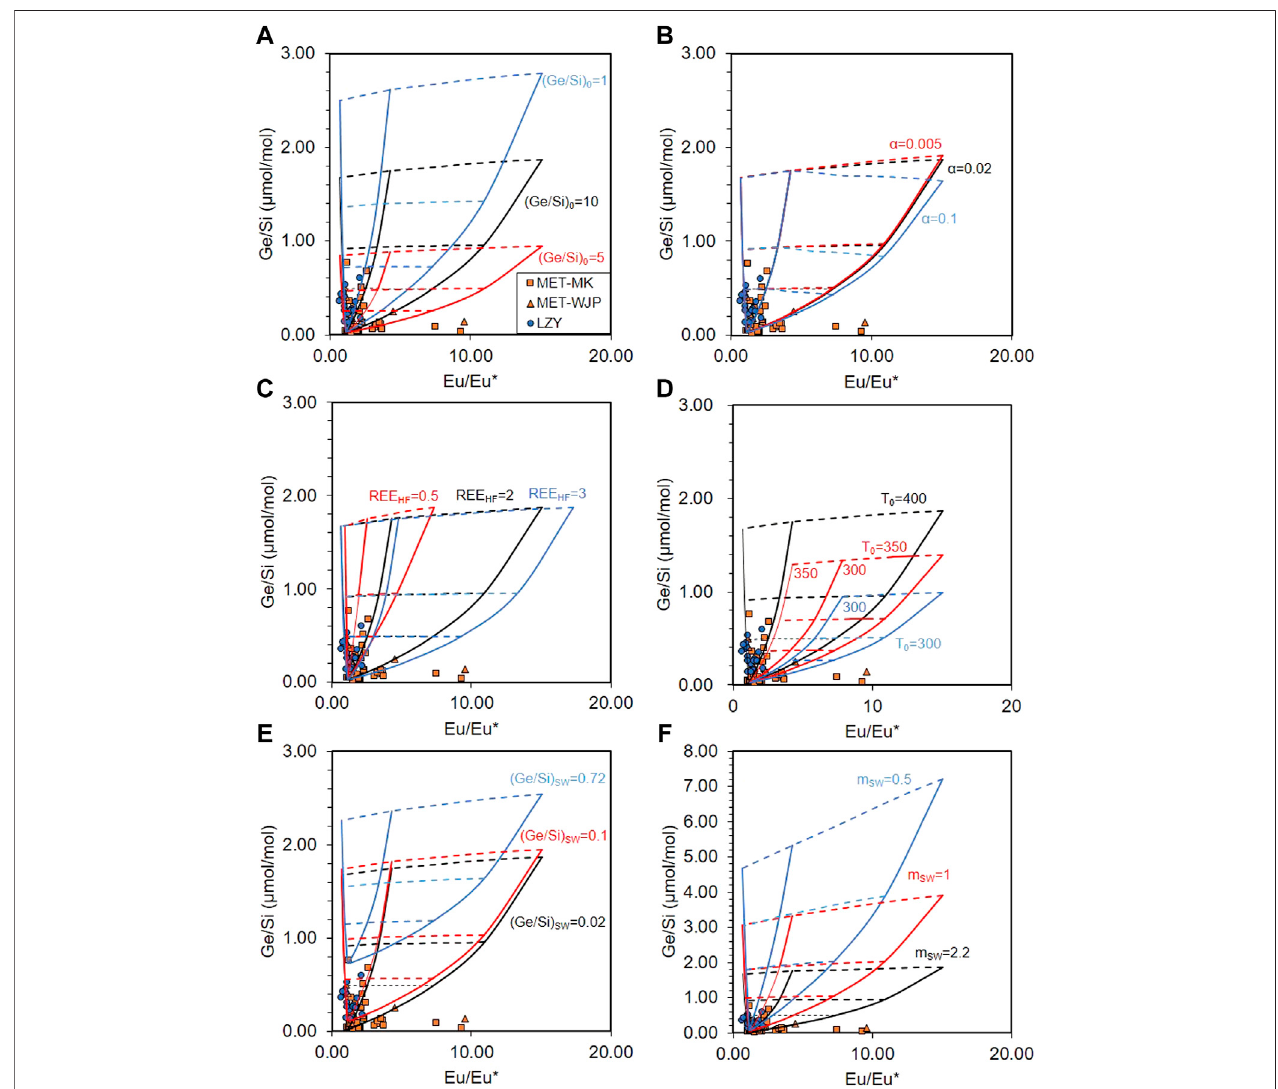
FIGURE 10 | Sensitivity tests of the binary-mixing model. The initial default parameters are (Ge/Si) 0 = 10 μ mol/mol, α = 0.02, REE HF = 2.0 ppb, T 0 = 400 ° C, (Ge/ Si) SW = 0.02 μ mol/mol, and m SW = 2.2 mM. Thesensitivityofparametersare tested byadjusting asingle parameter, (A) (Ge/Si) 0 ; (B) α ; (C) REE HF ; (D) T 0 ; (E) (Ge/Si) SW ; and (F) m SW ; while the other parameters are fi xed at the default values. Thecontourlines represent hydrothermal fl uid temperatureof 400 ° C, 350 ° C, and 200 ° C in (A – C) and (E,F) . The dashed lines represent the volume fraction of hydrothermal fl uid (2%, 1%, and 0.5%). The modeling results indicate that the estimated mixing ratios are not sensitive to the values of the aforementioned